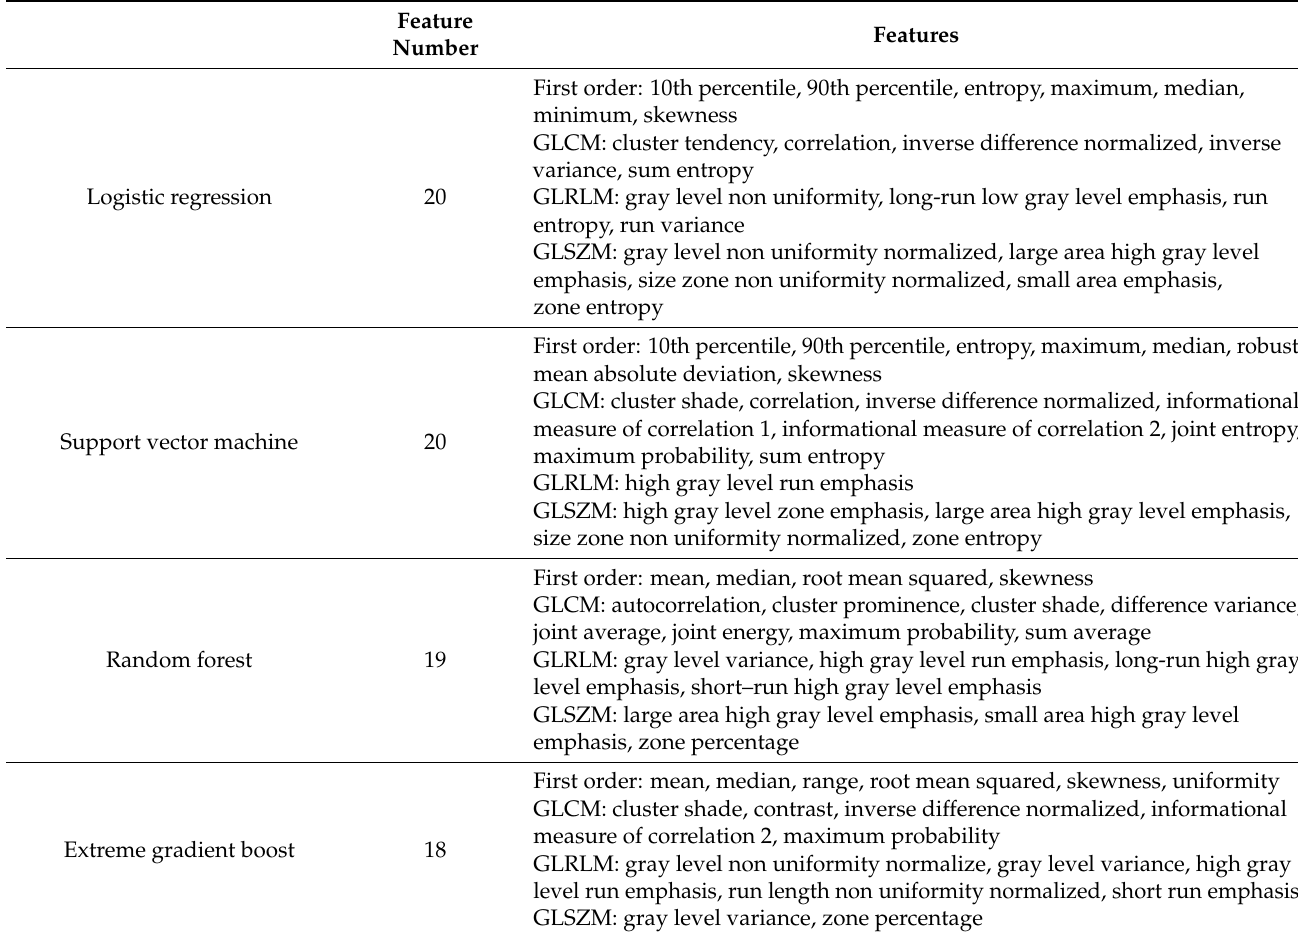
Table 1. Selected features from machine learning